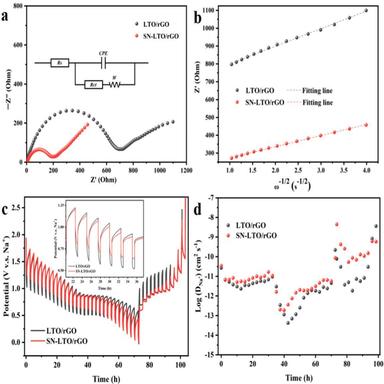
(a) EIS spectra of LTO/rGO and SN-LTO/rGO (the inset in (a) is the equivalent circuit model); (b) The plots of Z′ and ω−1/2 of the LTO/rGO and SN-LTO/rGO; (c) GITT curves of LTO/rGO and SN-LTO/rGO during the first time (the inset in (c) is the amplified time region from 23 to 37 h to compare the degree of polarization); (d) Na+ diffusion coefficient of LTO/rGO and SN-LTO/rGO under the charge and discharge processes.